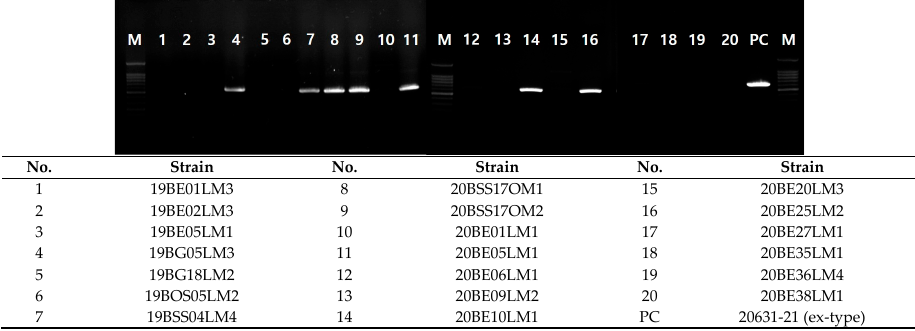
Figure 3. Confirmation of Pseudogymnoascus species by Pd -specific diagnostic primers. All the isolated Pseudogymnoascus species were verified using a Pd -specific diagnose primer. Of the 20 fungi, excluding positive control, 7 tests were positive [45] .